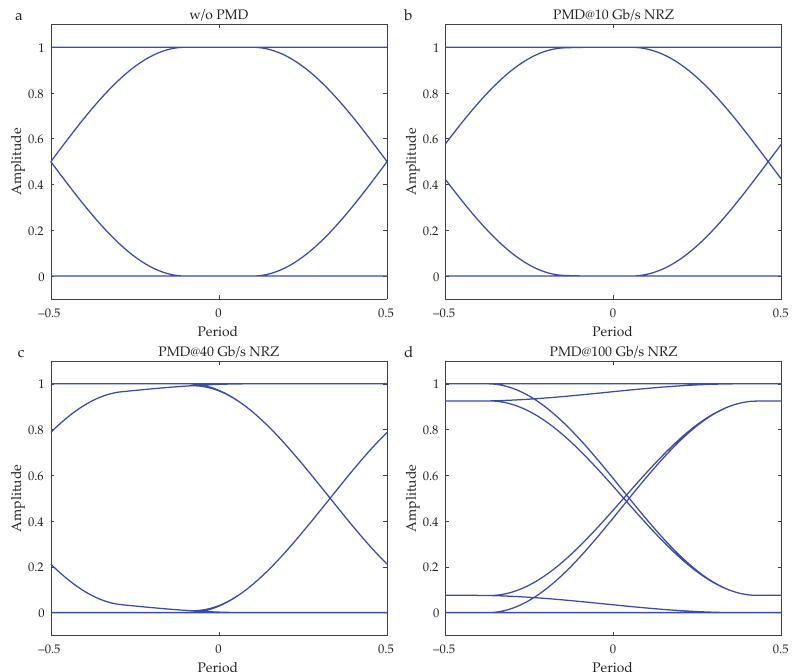
Figure 10. Eye diagrams impacted by PMD under strong wind conditions for different transmission bit rates. ( a ) Reference eye diagram at 10 Gbps without the impact of PMD. Wind-impaired eye diagrams for bit rates of: ( b ) 10 Gbps, ( c ) 40 Gbps, and ( d ) 100 Gbps. To calculate the signal degradation, the following parameters were considered: ∆ τ = 9.493 ps and PSP = [ − 0.182,0.497,0.849 ] .